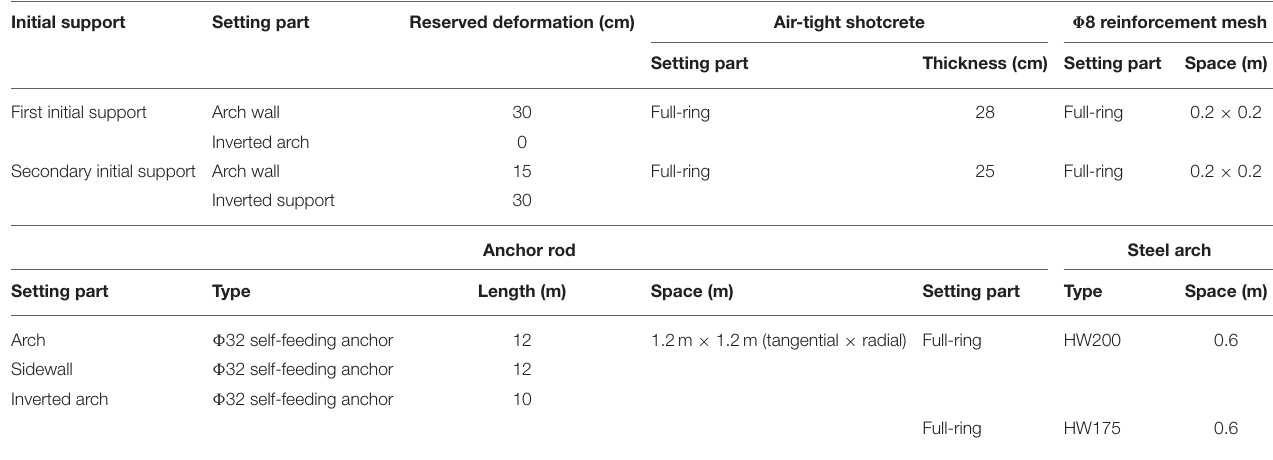
TABLE 4 | Parameters of type IV composite